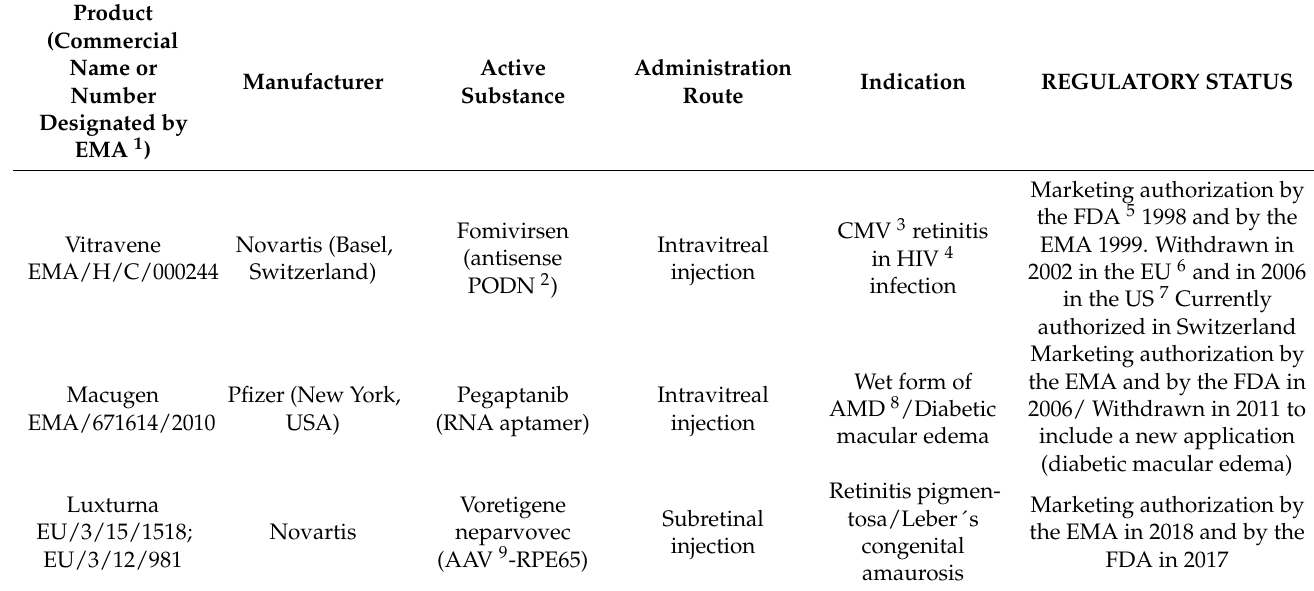
Table 3. Gene therapy medicinal products for the